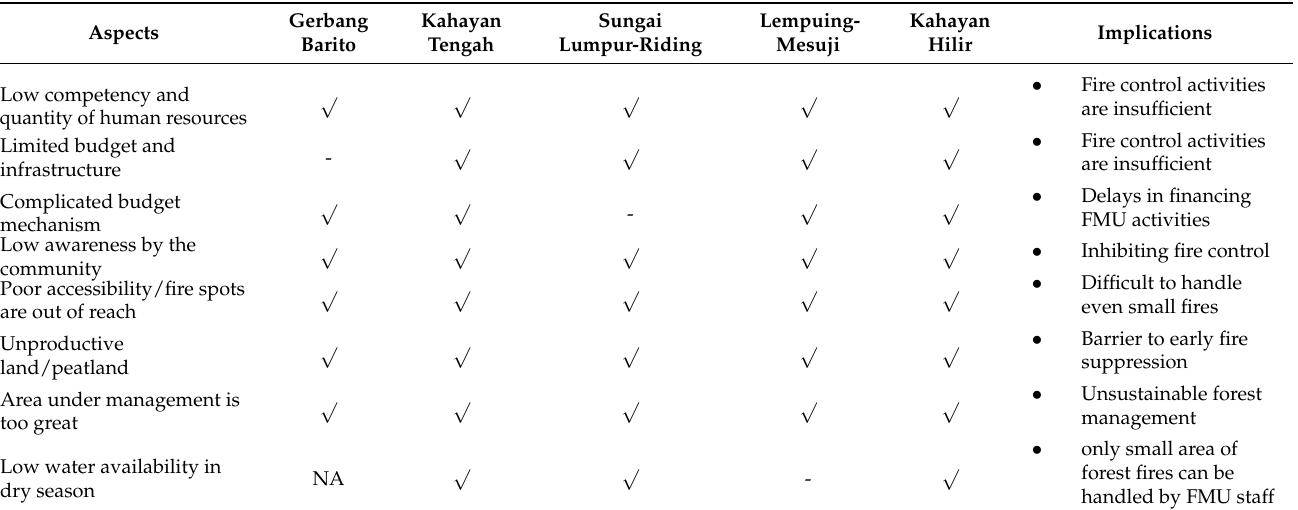
Table 5. The constraints reported by FMUs in forest fire control. Establishment of each given activity √ by each of the FMUs is signified by a ‘